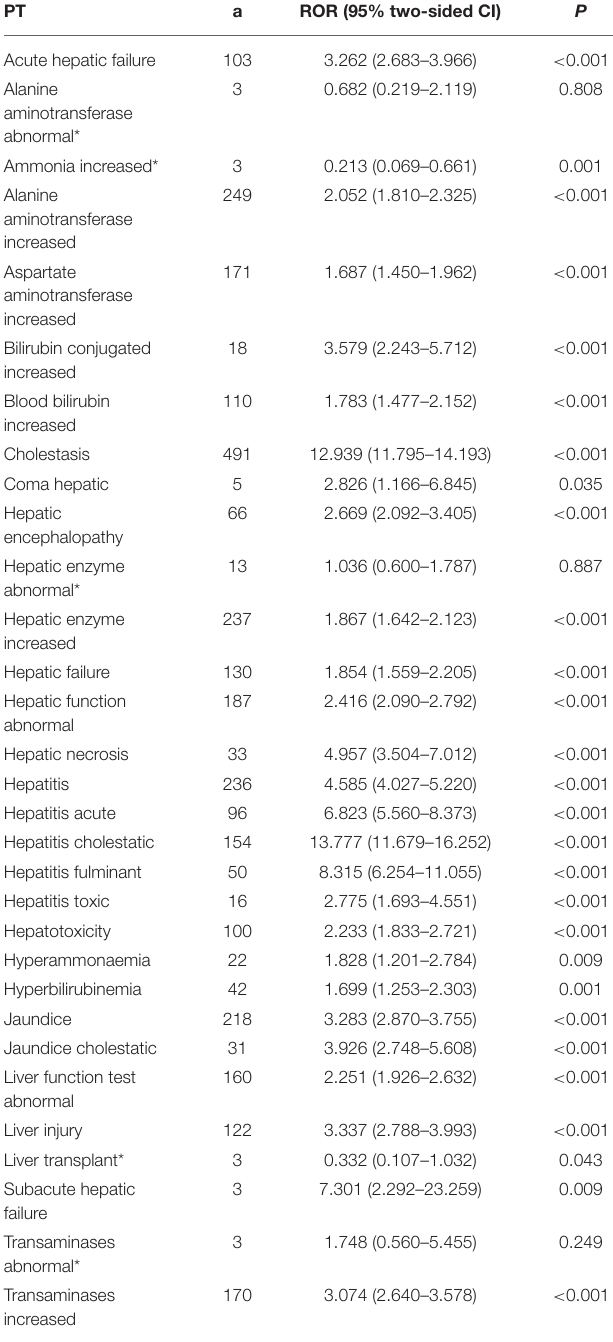
TABLE 1 | The number of cases and RORs of HRAE associated with all